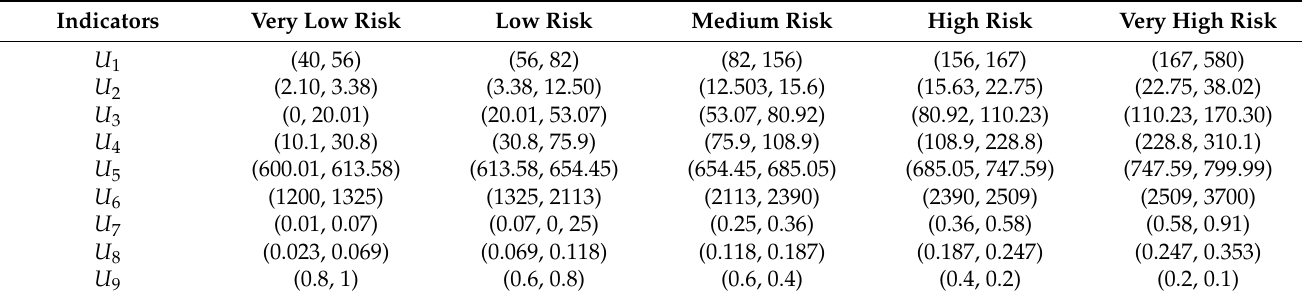
Table 5. Flood disaster risk assessment index system standard of Anyang City.